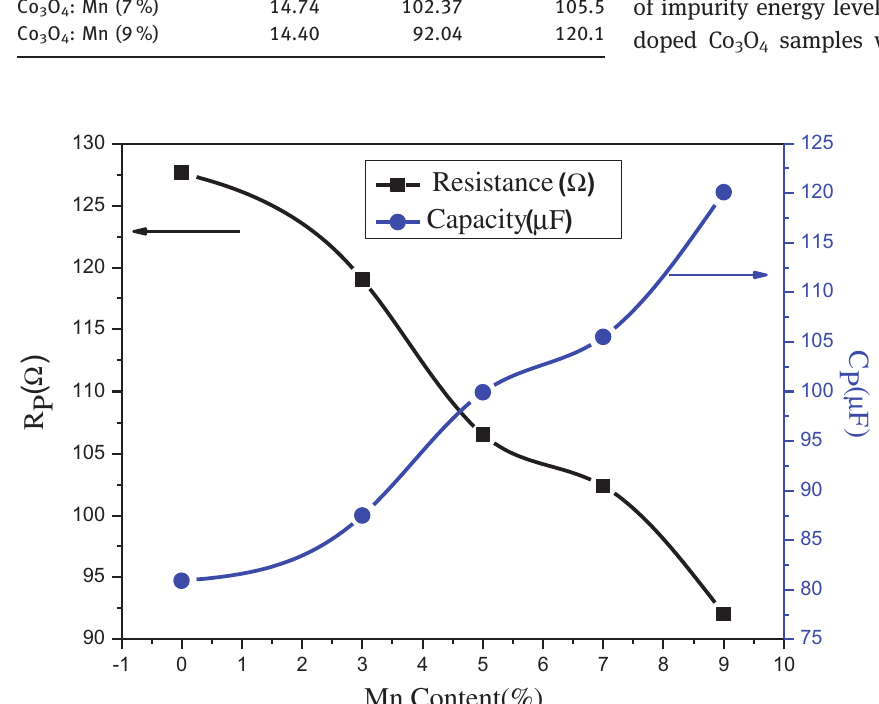
Figure 11: Variation of capacity and resistance of Mn-doped Co 3 O 4 thin